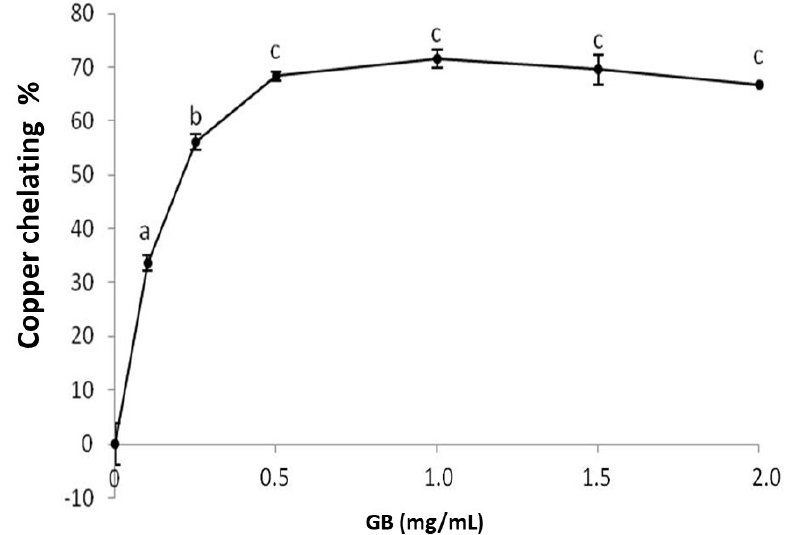
Figure 3. Copper chelating activity of GB. Data are expressed as mean ± standard deviation for three experiments. The letters “a–c” indicate a significant di ff erence ( p < 0.05) between concentrations experiments. The letters “a–c” indicate a significant difference ( p < 0.05) between concentrations obtained using one-way ANOVA, followed by the Student-Newman-Keuls test ( p < obtained using one-way ANOVA, followed by the Student-Newman-Keuls test ( p < 0.05).